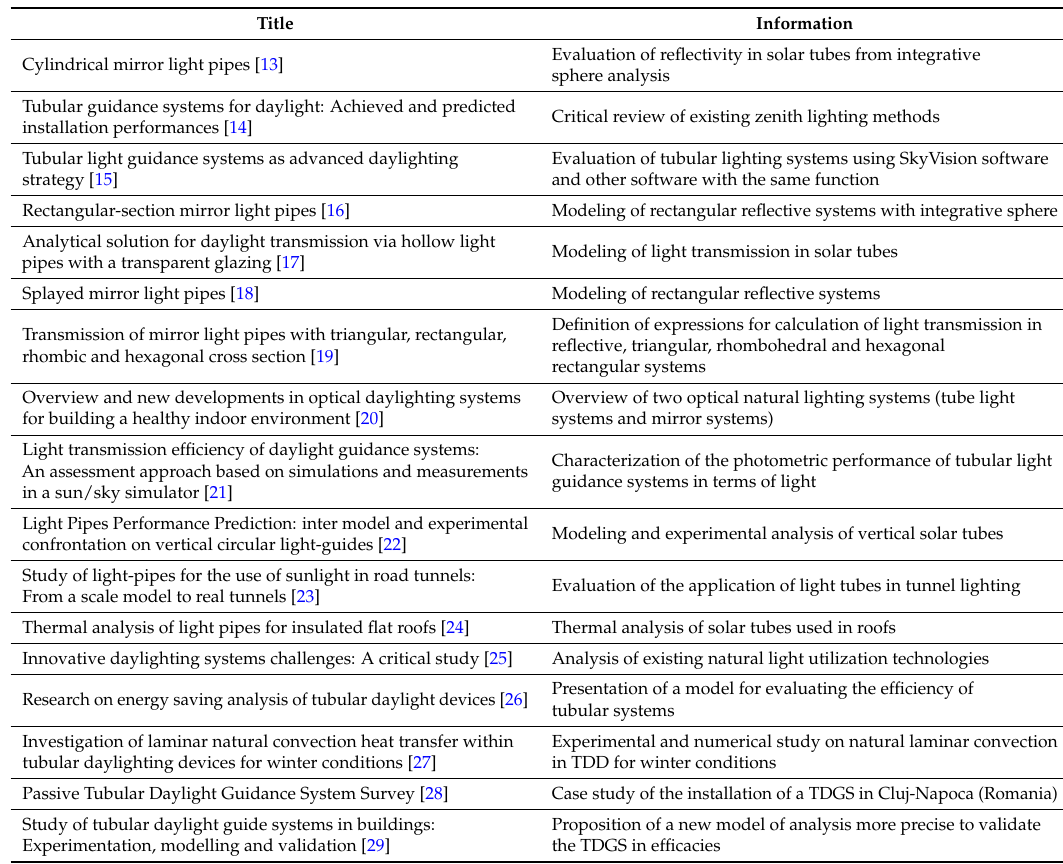
Table 2. Research